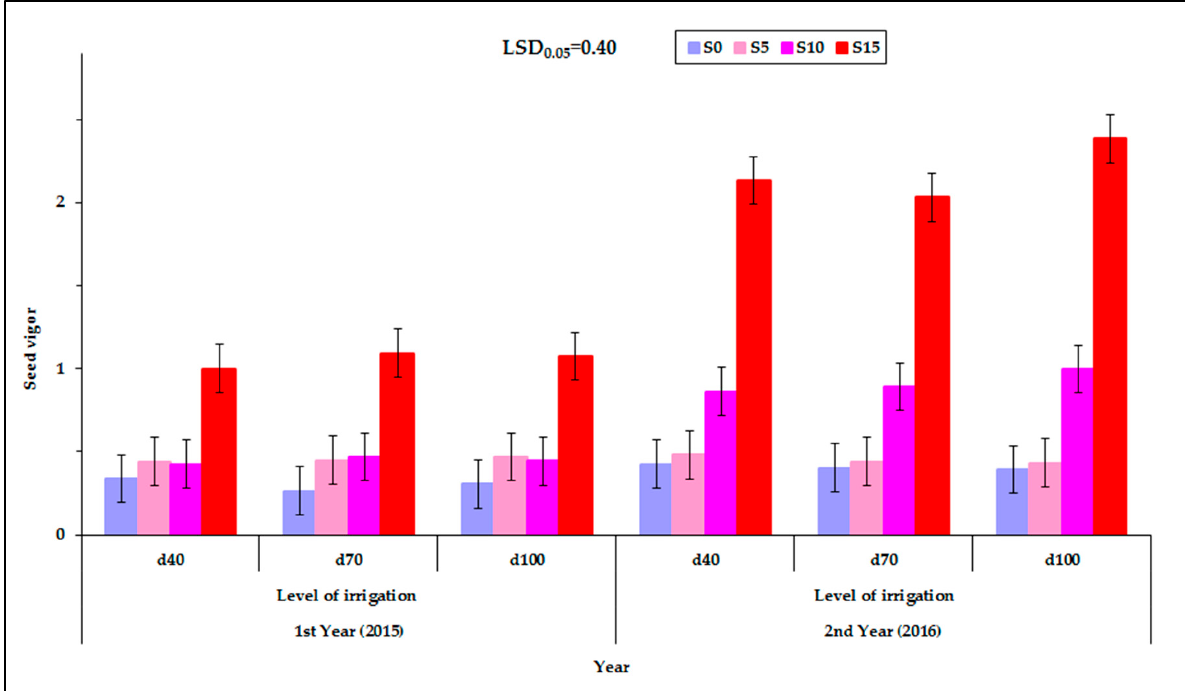
Figure 9. Seed vigor at the three levels of irrigation (d 40 , d 70 , and d 100 ), at the four PEG concentrations (S 0 , S 5 , S 10 and d 15 ), at the two years of experimentation. Data presented are estimated mean values averaged over the five cultivars. LSD is the least significant difference at the 0.05 significance level. Error bars correspond to the estimated common standard error of the mean values. Each mean value has been estimated utilizing n = 20 measurements. Figure S9 (see Supplementary Material) presents the observed mean values and the corresponding individual standard